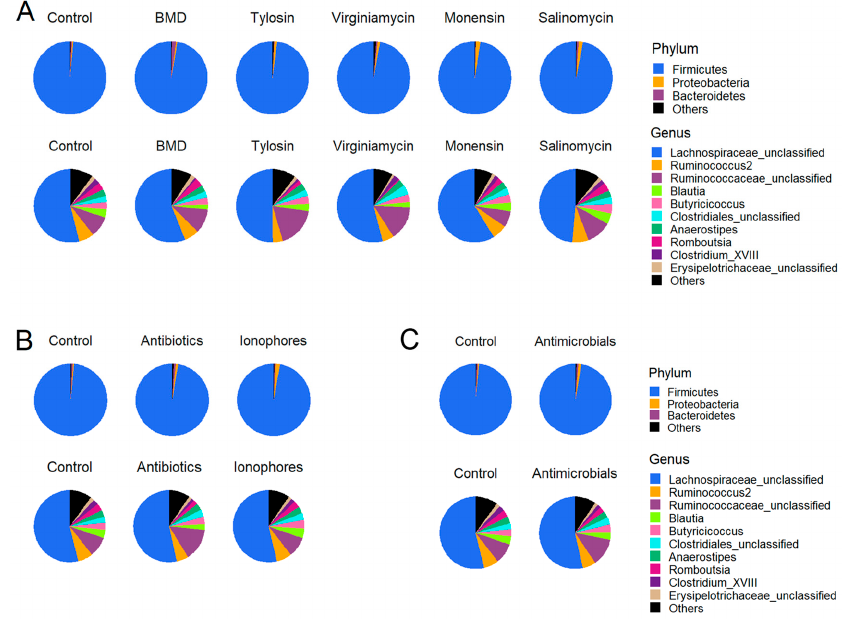
Figure 3. Differences in cecal microbiota composition of broilers following 2-week supplementation of different antimicrobials. Relative abundance of OTUs were calculated and plotted at the phylum and genus levels ( A ). Three antibiotics and two ionophore groups were further combined separately and relative abundance of OTUs were recalculated and plotted at the phylum and genus levels ( B ). All antimicrobial groups were combined and compared with the control group at the phylum and genus levels ( C ). Only the top three phyla and top 10 genera are shown, with unidentified and lowly abundant bacteria being collectively denoted as ′ Others ′ .